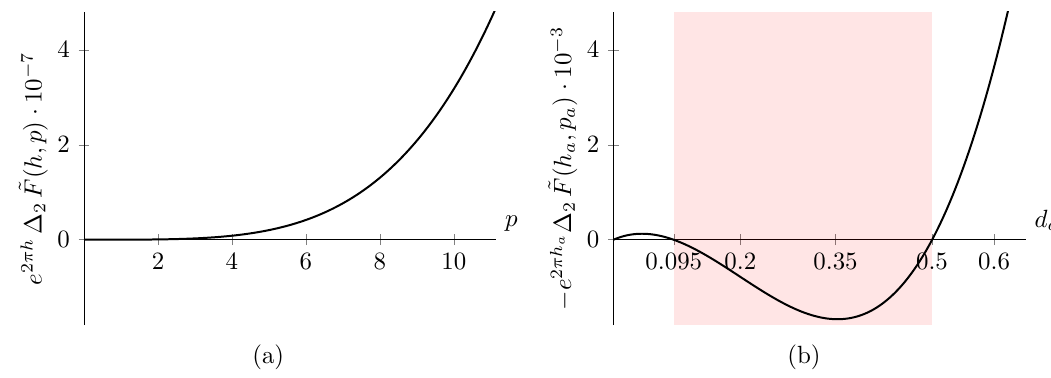
Figure 2. The contribution to the crossing equation (4.6) from (a) states with real-valued charges and (b) the state with imaginary charge p a 2 = d a . If d a lies in the shaded region, the WCFT (cid:0) must contain an additional state with imaginary